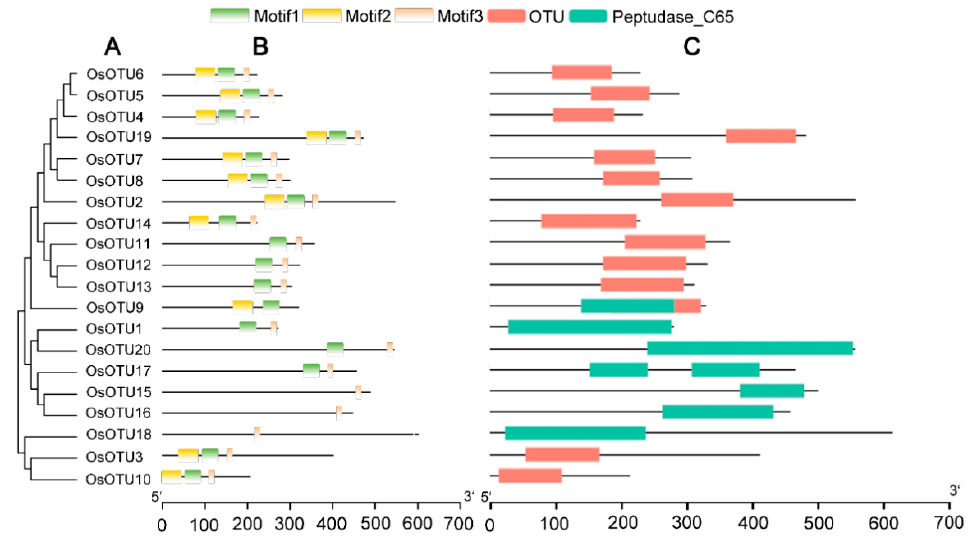
Figure 1. Phylogenetic tree, motif analysis of OTUs, and conserved domain. ( A ) Phylogenetic analysis of OsOTU proteins in rice. ( B ) Conserved motif analysis of OsOTUs using MEME tools. Motifs are shown in different colored rectangles. ( C ) Conserved domain distributions of the out proteins in rice. The OTU domain and The Peptudase C65 domain are indicated in red and blue rectangles, respectively.